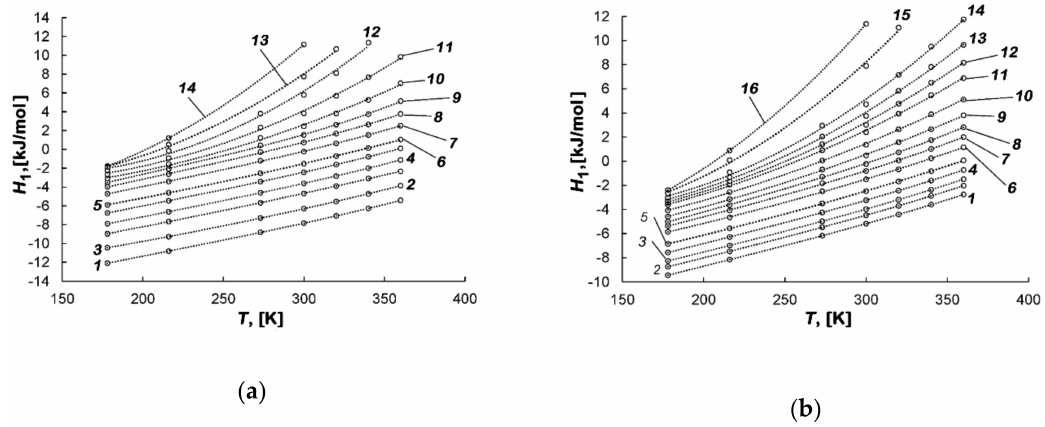
Figure 9. Temperature dependence of the di ff erential molar enthalpy of the methane-AC-4 ( a ) and methane-AC-6 ( b ) adsorption systems at the values of adsorption a , mmol / g: 0.1 ( 1 ), 0.3 ( 2 ), 0.6 ( 3 ), 1 ( 4 ), 1.5 ( 5 ), 2 ( 6 ), 3 ( 7 ), 4 ( 8 ),5 ( 9 ), 6 ( 10 ), 7 ( 11 ), 7.8 ( 12 ), 8.3 ( 13 ), 8.8 ( 14 ) ( a ) and 0.1 ( 1 ), 0.6 ( 2 ), 1 ( 3 ), 1.5 ( 4 ), 2 ( 5 ), 3 ( 6 ), 4 ( 7 ), 5 ( 8 ), 6 ( 9 ), 7 ( 10 ), 8 ( 11 ), 8.5 ( 12 ), 9 ( 13 ), 9.5 ( 14 ), 10.5 ( 15 ), 11 ( 16 ) ( b